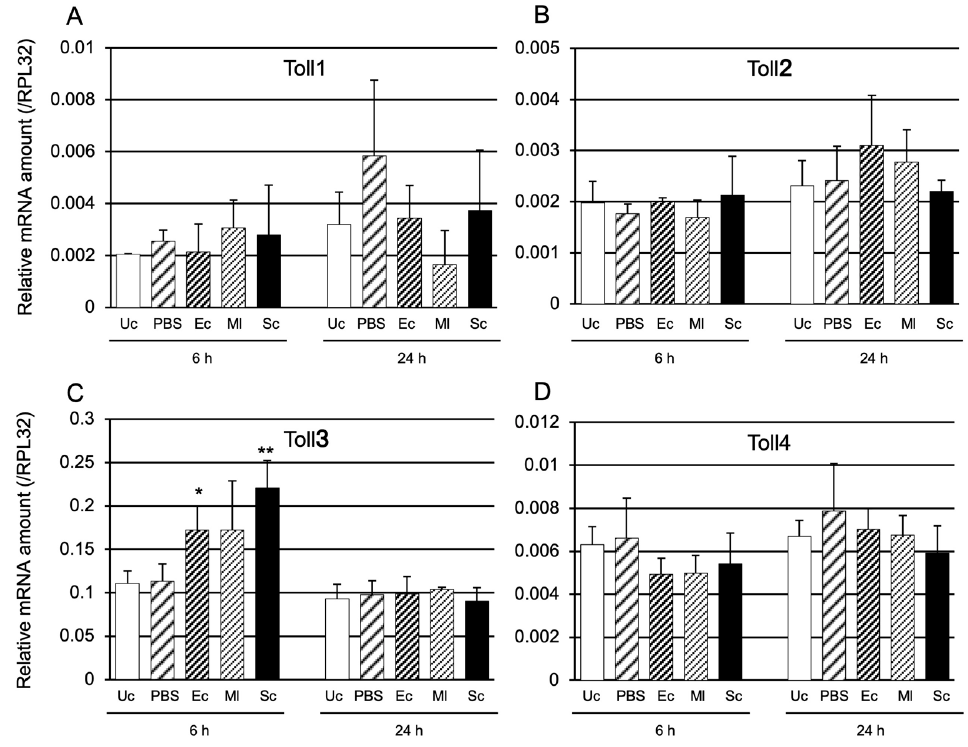
Figure 2. mRNA expression levels of Toll1 ( A ), Toll2 ( B ), Toll3 ( C ), and Toll4 ( D ) after challenge with three types of microbe. Day-3 pupae were challenged with heat-killed E. coli (Ec), M. luteus (Ml), or S. cerevisiae (Sc). The relative mRNA levels of Toll1 ( A ), Toll2 ( B ), Toll3 ( C ), and Toll4 ( D ) in the pupae were measured at 6 and 24 h post-injection. Unchallenged (Uc) and phosphate-buffered saline (PBS) injected pupae were used as negative controls. The mRNA amounts of the two genes are shown as relative values to ribosomal protein L32 ( RPL32 ) levels in the same samples. Experiments with three animals were independently repeated three times, and each column represents the mean ± S.D. Asterisks and double-asterisks indicate p < 0.05 and p < 0.01 of Student’s t -test compared to Uc samples, respectively.